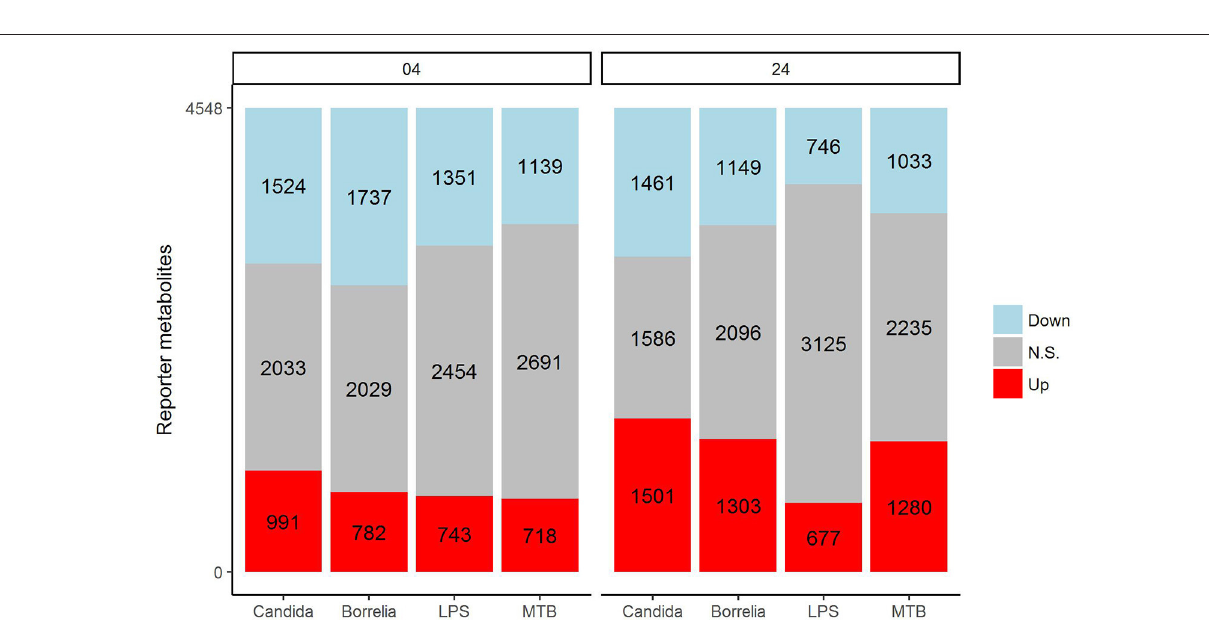
FIGURE 7 | Distribution of significantly up-regulated (red), down-regulated (blue), and not significantly changed (gray) reporter metabolites for Candida , Borrelia , LPS, and MTB-stimulated human PBMCs at 4 and 24 h. When a reporter metabolite has FDR < 0.05, it is